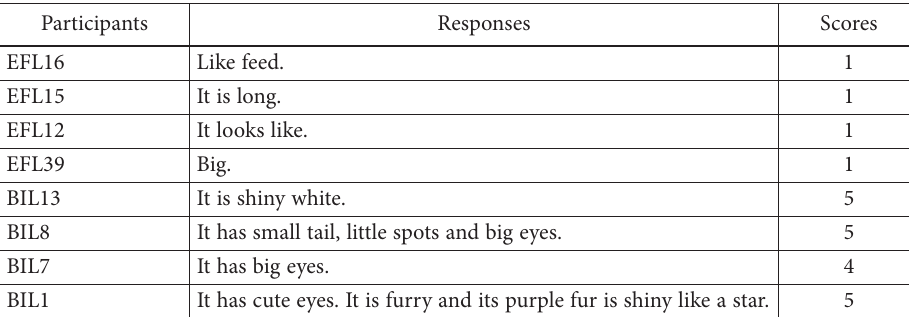
Table 8. Sample assessment of the responses from English as foreign language (EFL) and bilingual (BIL) groups (source: created by authors)